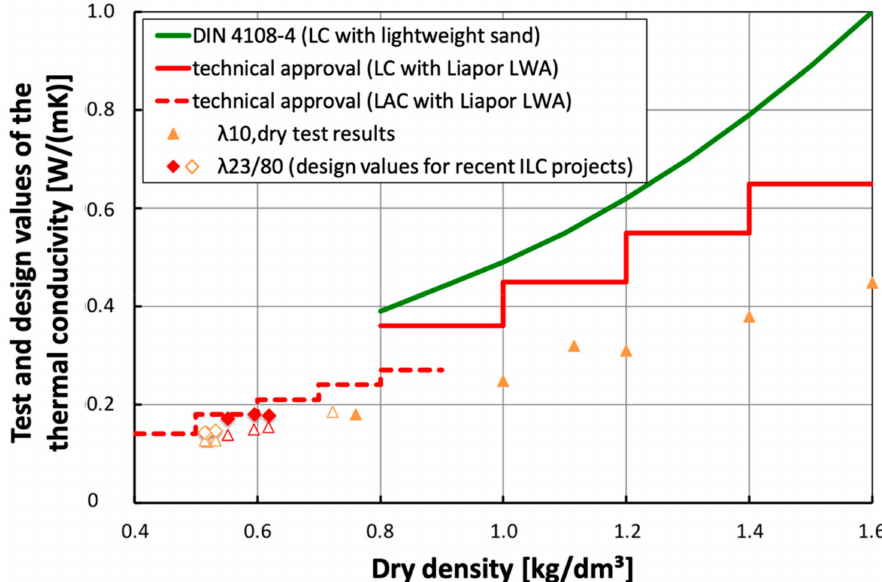
Figure 9. Correlation between thermal conductivity and dry density for LC, LAC taken from technical approvals [140,141], data published for several LC and two ILC projects [18,48] as well as for most recent LAC-based ILC projects [49].